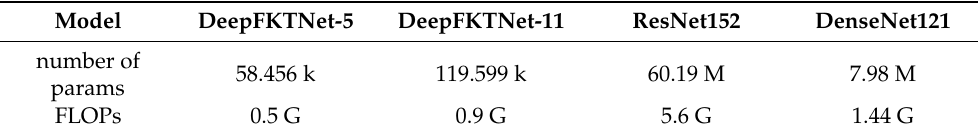
Table 4. The comparison between generated DeepFKTNet models from the two datasets and pre- trained ResNet152 and DenseNet121. K is for kilobyte and G is for